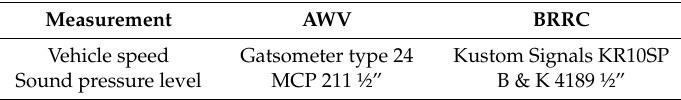
Table 2. SPB measurement equipment.